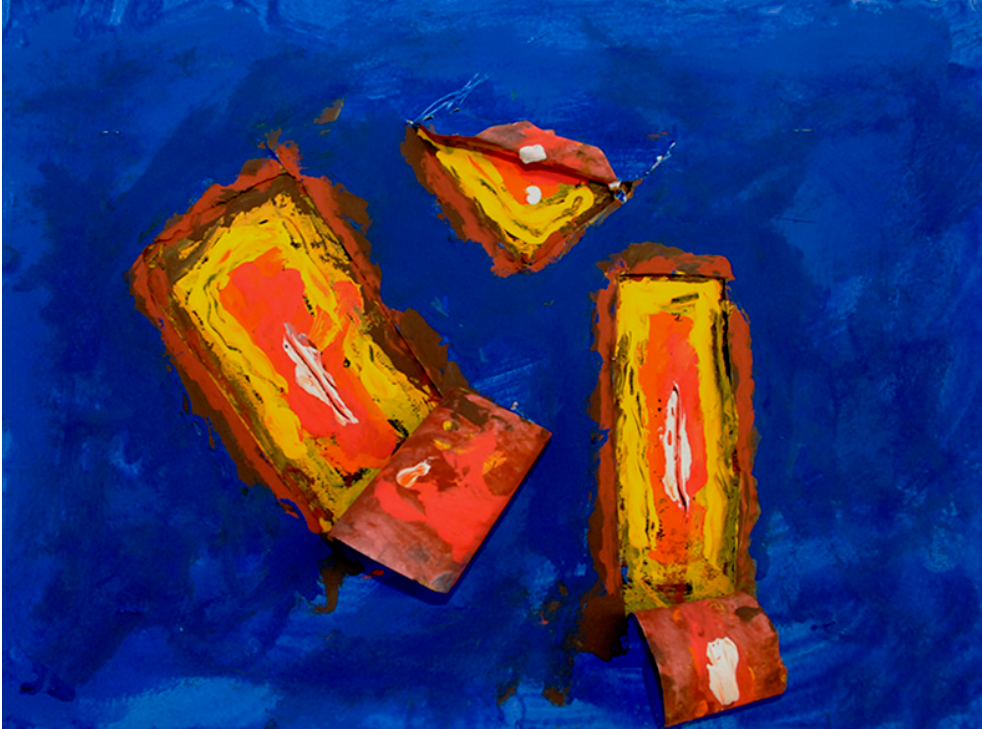
Figure 4. Tommaso (aged 28, depressive borderline personality disorder), Wounds that Open and Close Like Sardine